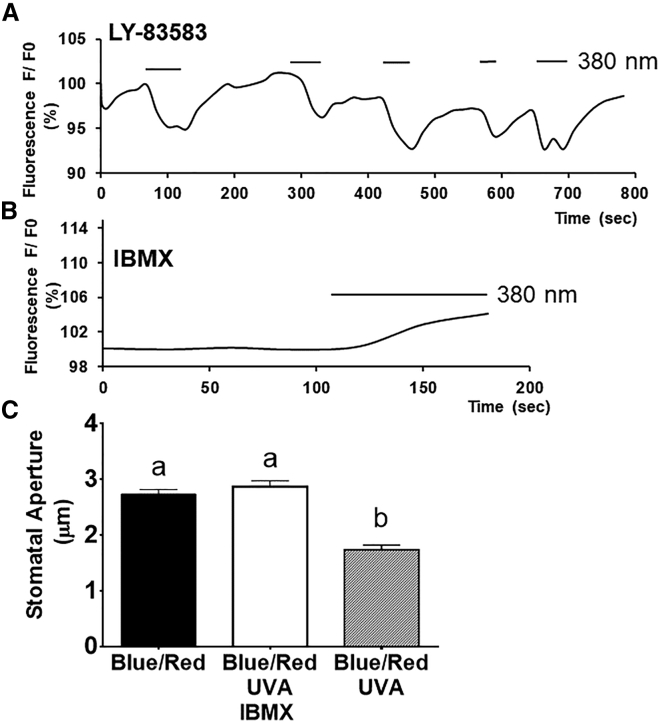
Effect of Cyclic Nucleotide Metabolism Inhibitors on UVA-Induced Responses(A) The guanylyl cyclase inhibitor LY-83583 partially interferes with UVA-induced reductions in δ-FlincG fluorescence. Mesophyll protoplasts were treated with 50 μM LY-83583 for 10 min, followed by pulses of UVA (10 μmol m−2 s−1 [λmax = 380 nm]), and fluorescence was recorded (representative graph of 3 experiments).(B) The phosphodiesterase inhibitor IBMX inhibits UVA-induced reductions in fluorescence (representative graph of 3 experiments). Mesophyll protoplasts were incubated with 50 μM IBMX for 10 min and δ-FlincG fluorescence was subsequently recorded in the presence of UVA (10 μmol m−2 s−1 [λmax = 380 nm]).(C) IBMX prevents UVA-induced inhibition of blue- and red-light-induced stomatal opening. Arabidopsis epidermis was incubated in 10 mM MES/KOH, 50 mM KCl, pH 6.15 and illuminated with 10 μmol m−2 s−1 blue (λmax = 470 nm) and 50 μmol m−2 s−1 red (λmax = 660 nm) in the presence or absence of 10 μmol m−1 s−1 UVA (λmax = 380 nm) and in the presence or absence of 50 μM IBMX. Stomatal apertures were measured after 3 h. Data represent means (+/− SEM) of 90 stomatal aperture measurements from three replicates. Statistical analyses were performed by one-way ANOVA with Tukey post hoc analysis, and letters show significant differences at p < 0.05.See also Figures S1 and S3.